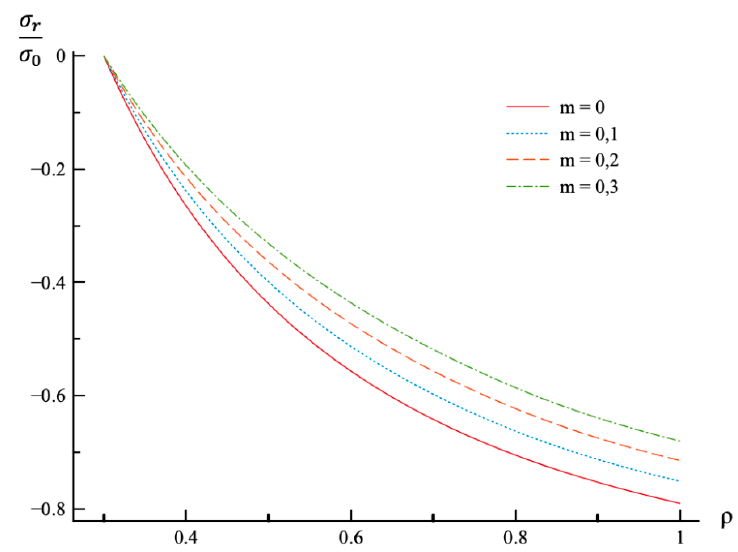
Figure 1. Variation of the radial stress, σ r , with the dimensionless radius, ρ , at p = p f .